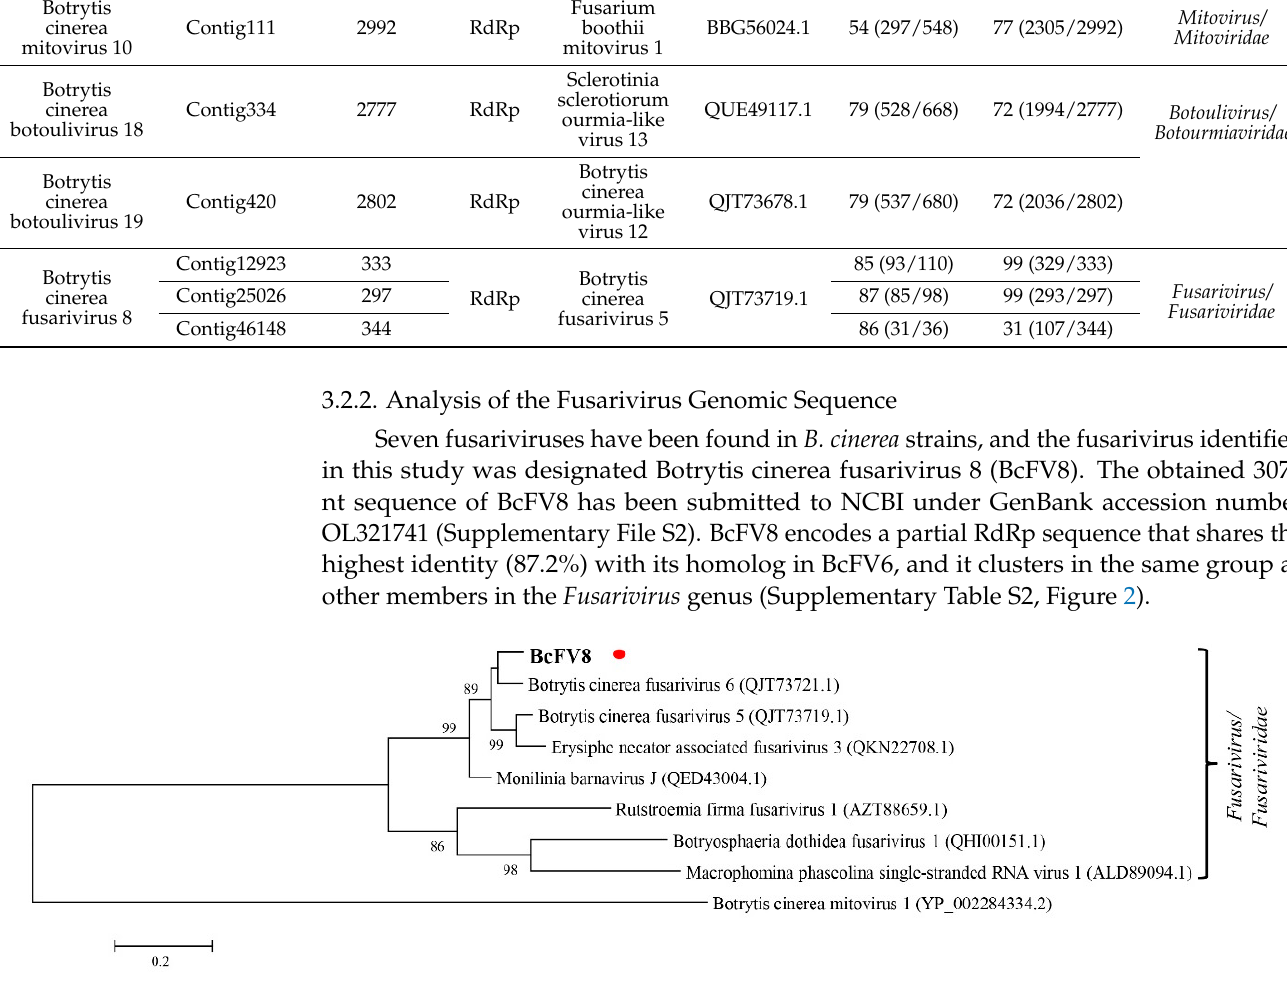
Figure 2. Phylogenetic tree analysis of the BcFV8 partial RdRp aa sequence with homologs from similar viruses. The BcFV8 identified in this study are represented in black body with red dot.